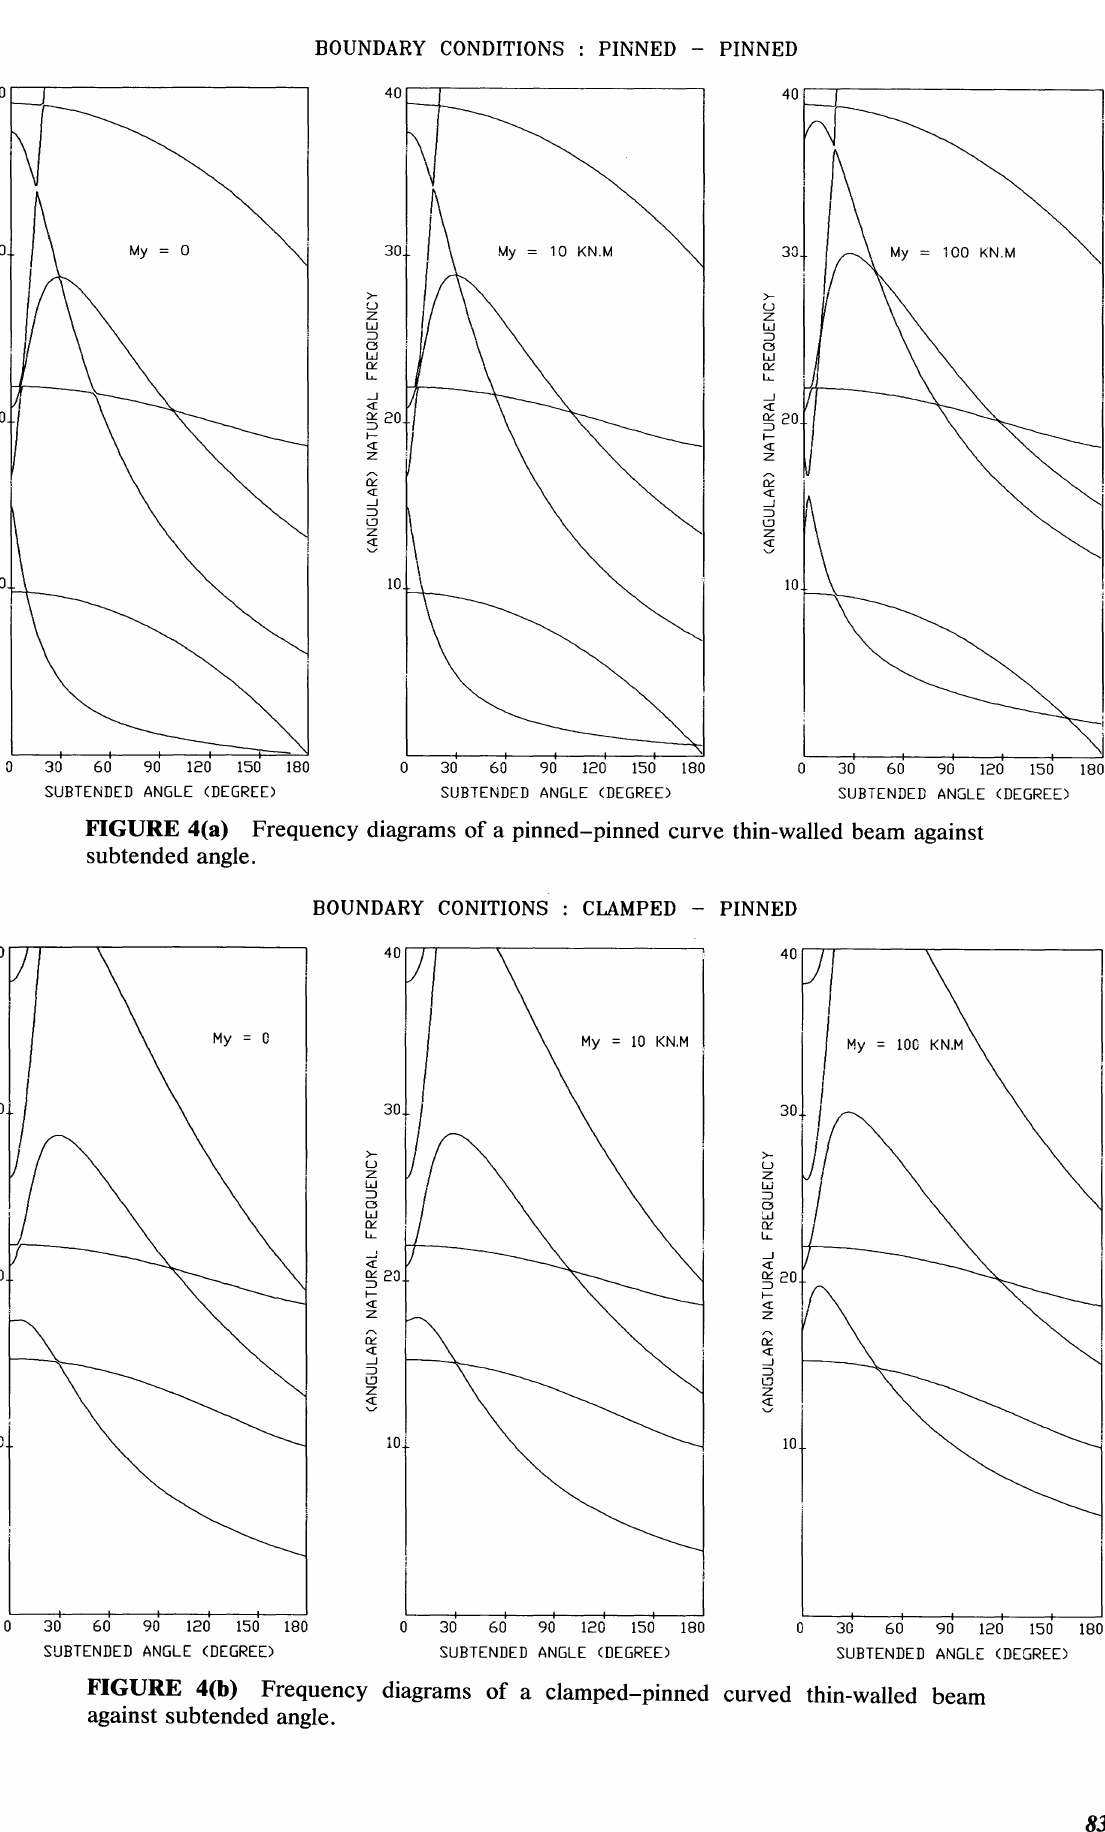
FIGURE 4(b) Frequency diagrams of a clamped-pinned curved thin-walled beam against subtended